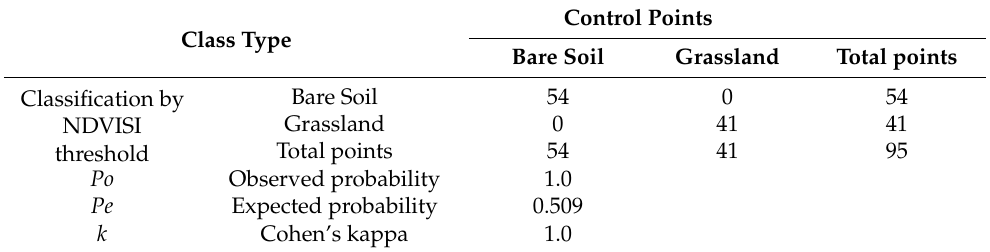
Table 7. Confusion matrix of “bare soil-grasslands” control points classification.